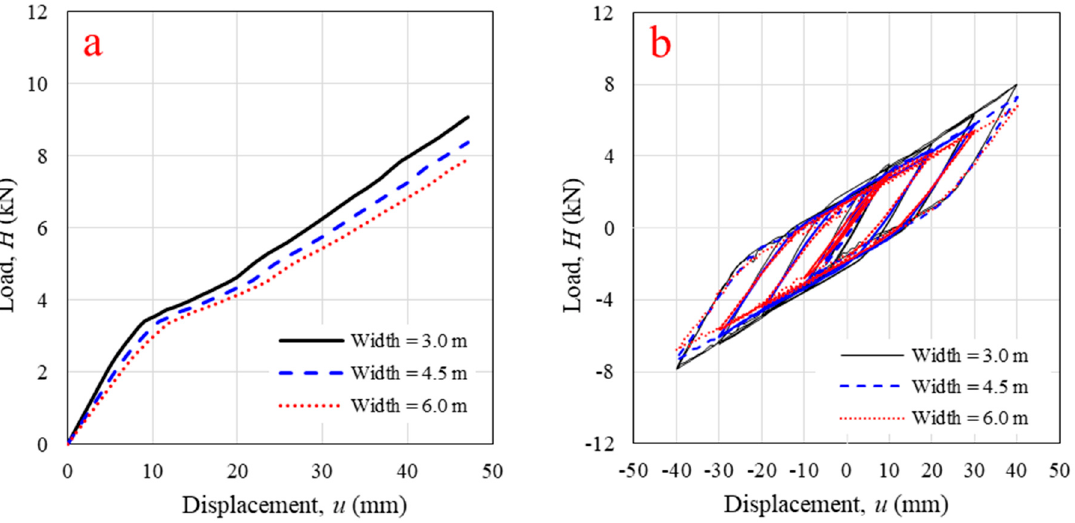
Figure 14. Horizontal in-plane lateral load versus displacement from validated numerical modeling with different log-wall widths under ( a ) monotonic loading; ( b ) cyclic loading. with different log-wall widths under ( a ) monotonic loading; ( b ) cyclic